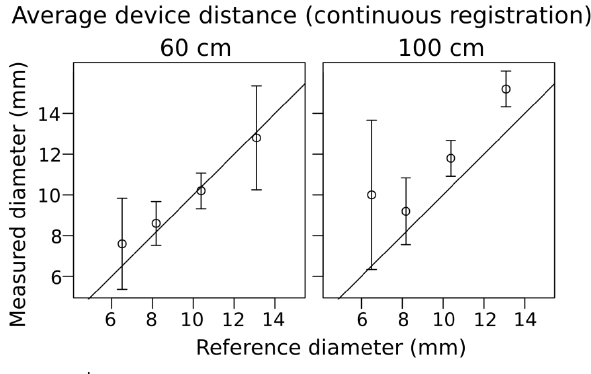
Figure 4. Comparison of reference and measured values for branches varying in diameter. Measured values were obtained from mesh generated using ReconstructMe and an Asus Xtion at 60 cm and 100 cm (other software tested did not yield measurable meshes). Circles show the mean of 5 scans and whiskers show 95% confidence intervals † for the mean; 1:1 relationship between reference and measured values indicated with a solid line.